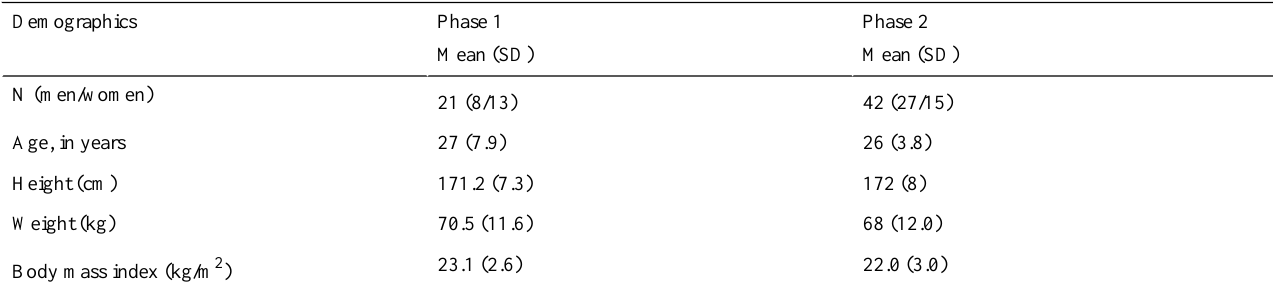
Table 1. Participant